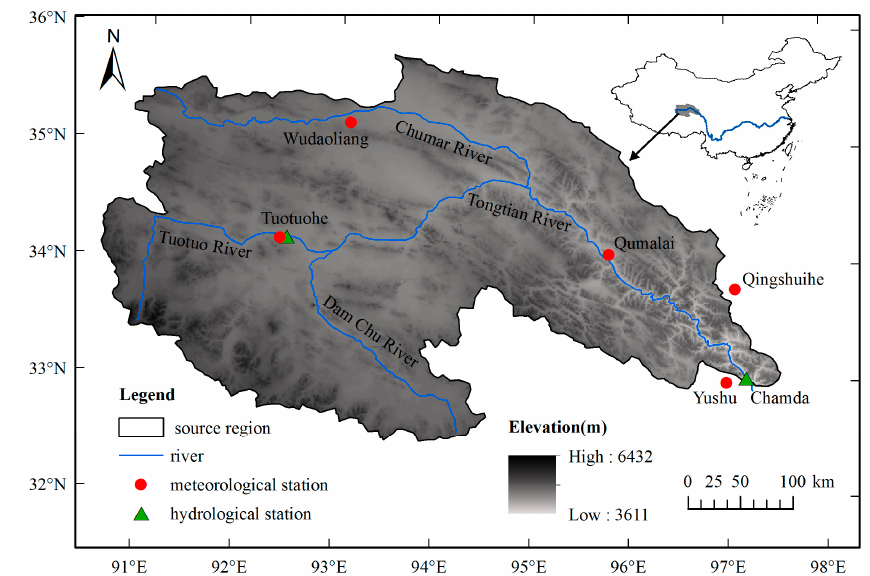
Figure 1. Location of the source region of the Yangtze River (SRYR) and stations.